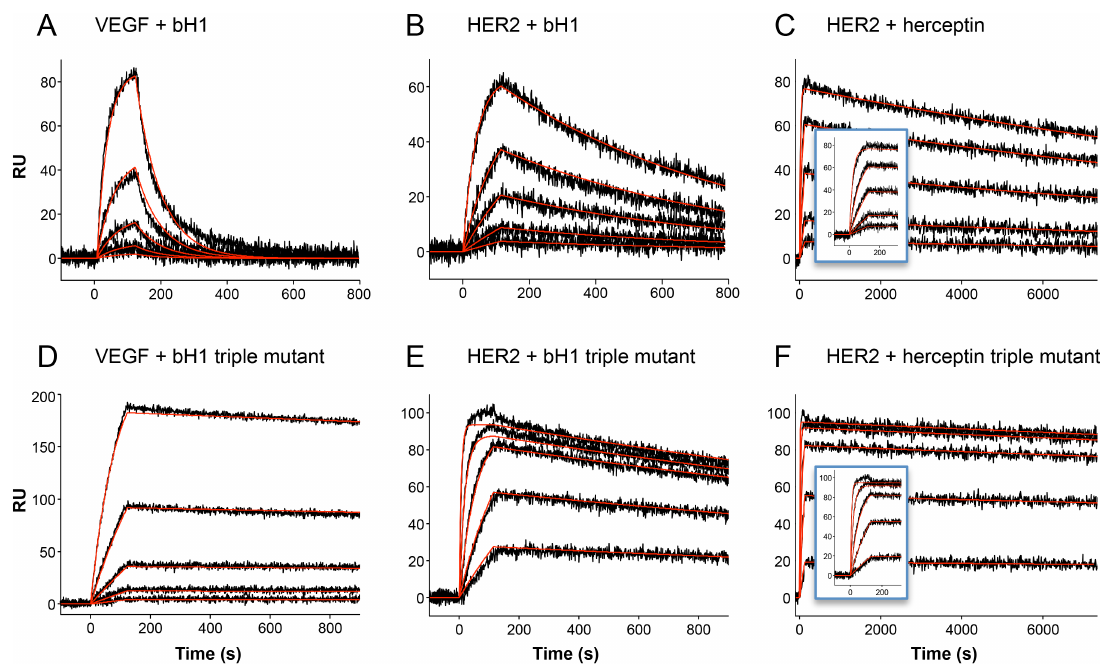
Fig 2. Sensorgrams of the parent Fabs and best triple mutant for each complex. The red curves represent the globalfits of the data to a 1:1 bimolecular interactionmodel. The slow off rates of Herceptinand its triple mutant requiredlongerdata acquisitiontimes in the dissociationphaseto obtain reliablekinetics. The insets in panels(C) and (F) are expandedviews of the associationphaseof these sensorgrams.